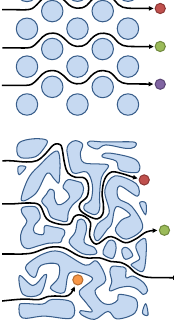
Figure 2. Schematic depiction of dispersion. Fluid movement through a microscopically homogeneous, low-tortuosity porous medium (upper panel) is non-dispersive; fluid movement through a microscopically disordered porous medium (lower panel) disperses tracer molecules. Macroscopic fluid flow is from left to